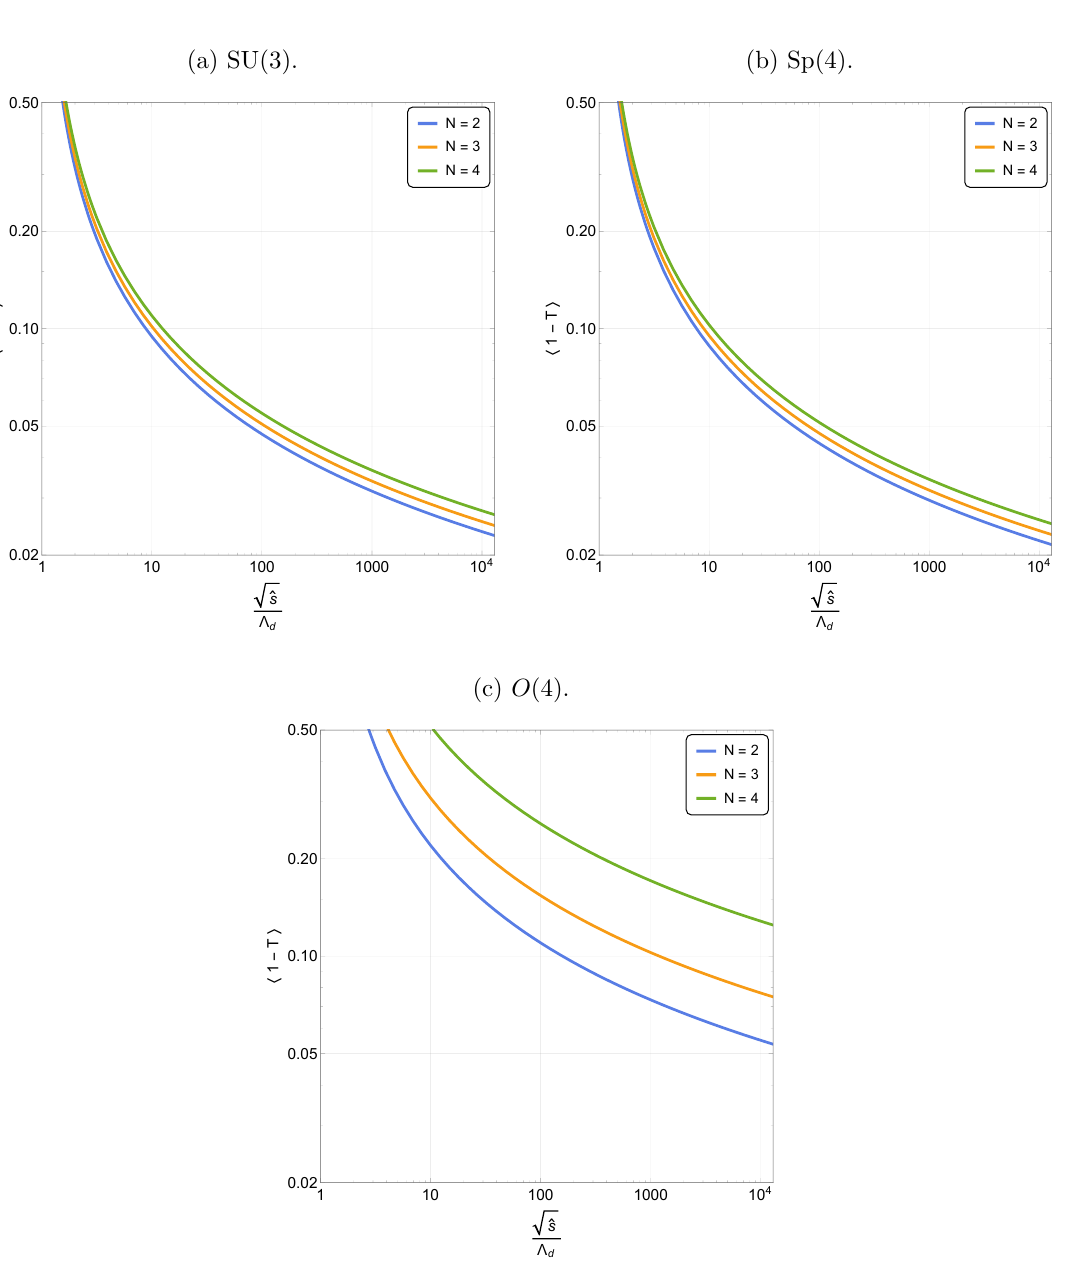
Figure 12. Theory prediction of the thrust as a function of the ratio (a), Sp(4) (b) and O (4) (c) for di(cid:11)erent values of N = 2 (blue), N = 3 (orange) and N = 4 (green).